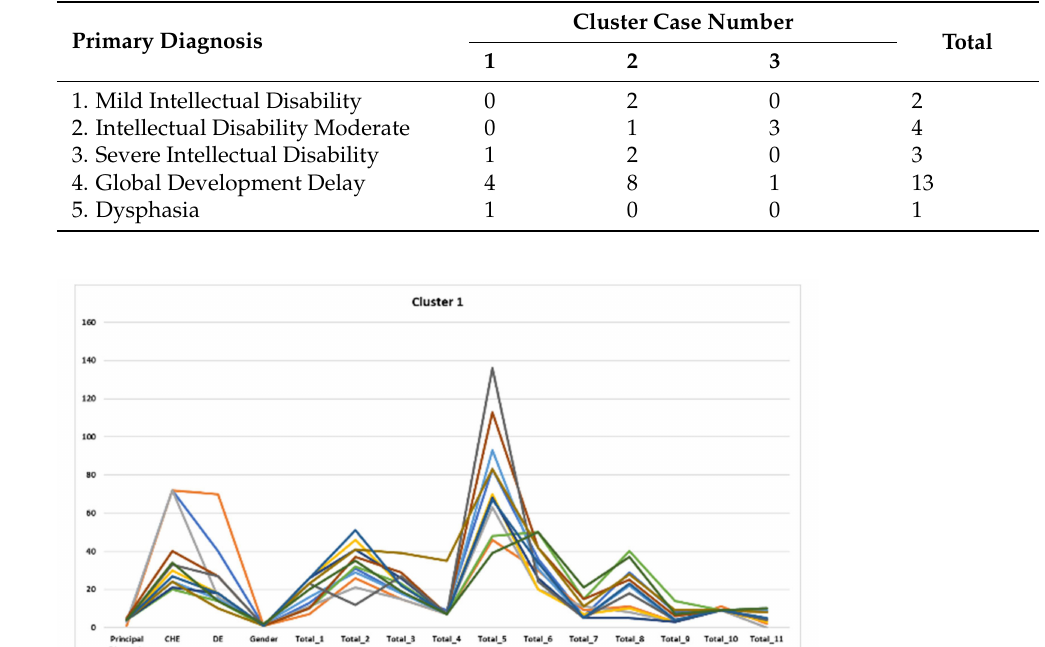
Table 5. Cross table between participant’s cluster and primary diagnosis.